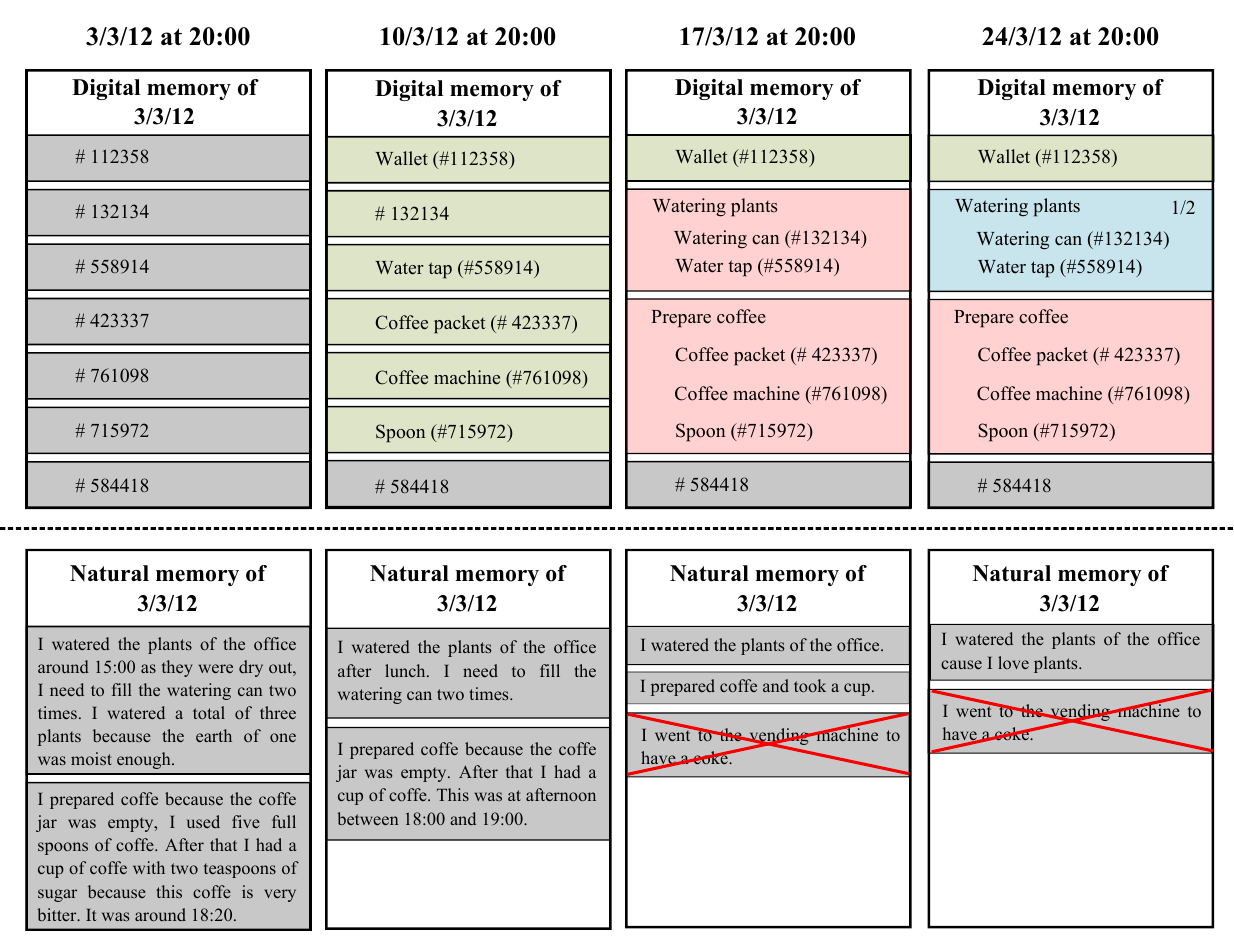
Figure 8. Comparison between Dig-Mem (top) and Natural Memory (bottom). Representation of a subset of data collected during the case study from the devices and the written stories written by the